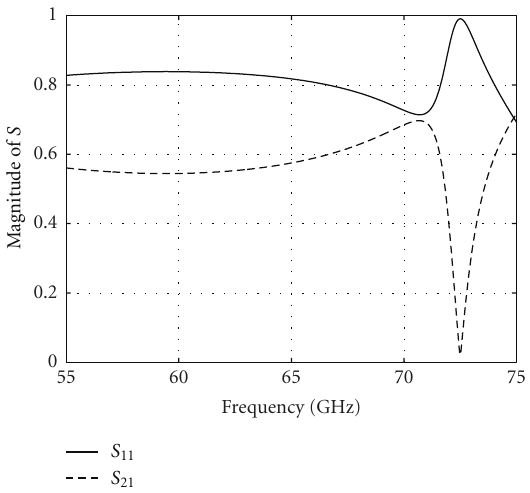
Figure 2: Magnitude of the transmission and reflection coe ffi cients of the square ring FSS cell.